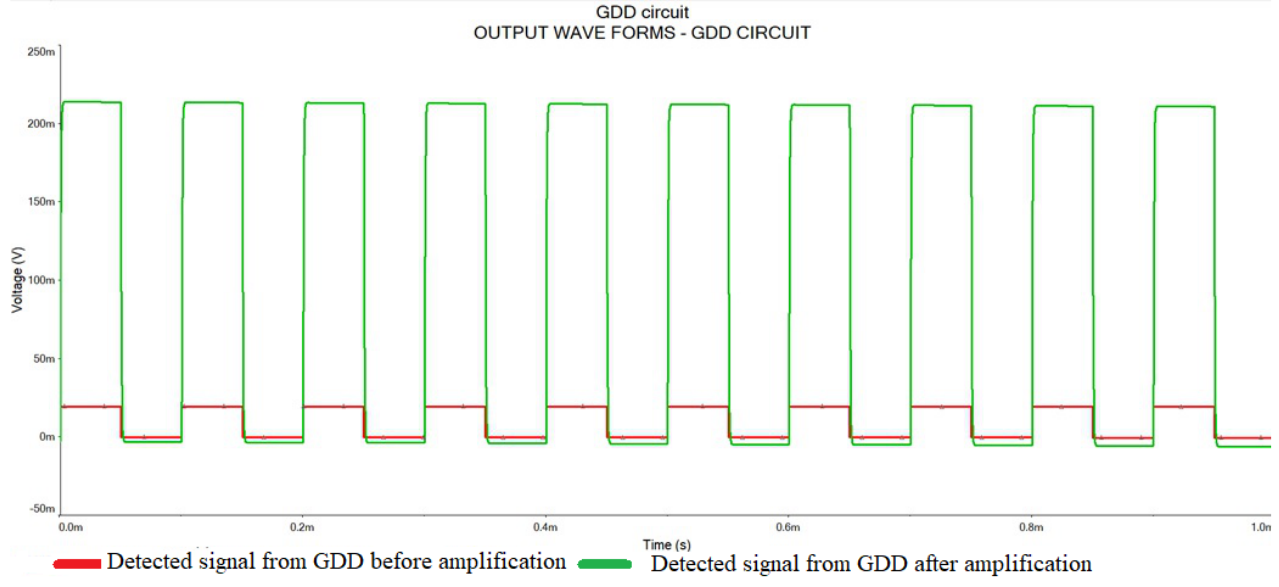
Figure 4. Output waveforms from the simulation of the GDD circuit.